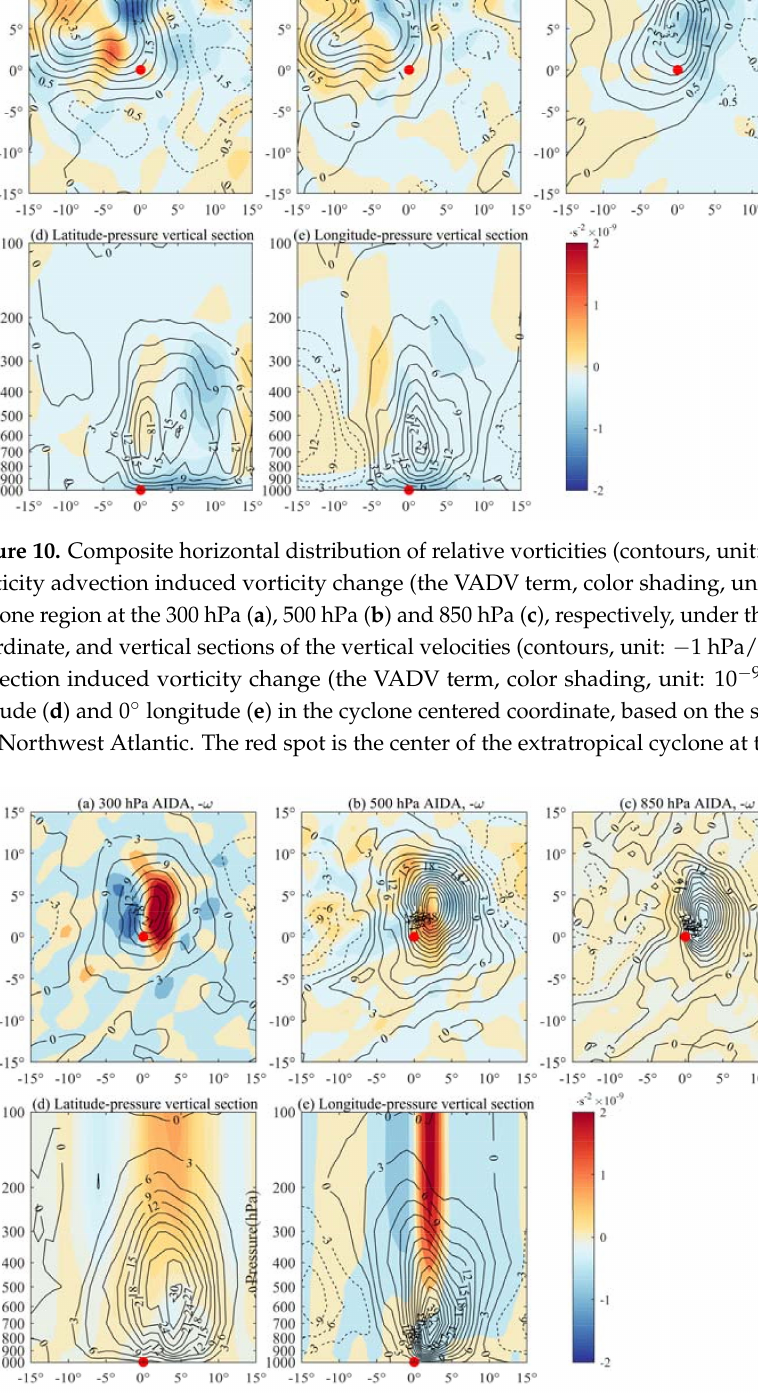
Figure 11. Composite horizontal distribution of the vertical velocities (contours, unit: − 1 hPa/s), and vertical motion induced vorticity change (the ADIA term, color shading, unit: 10 − 9 s − 2 ) in the cyclone region at the 300 hPa ( a ), 500 hPa ( b ) and 850 hPa ( c ), respectively, in the cyclone centered coordinate, and vertical sections of the vertical velocities (contours, unit: − 1 hPa/s) and vertical motion induced vorticity change (the ADIA term, color shading, unit: 10 − 9 s − 2 ) along the 0 ◦ latitude ( d ) and 0 ◦ longitude ( e ) in the cyclone centered coordinate, based on the selected cyclones in the Northwest Pacific. The red spot is the center of the extratropical cyclone at the sea